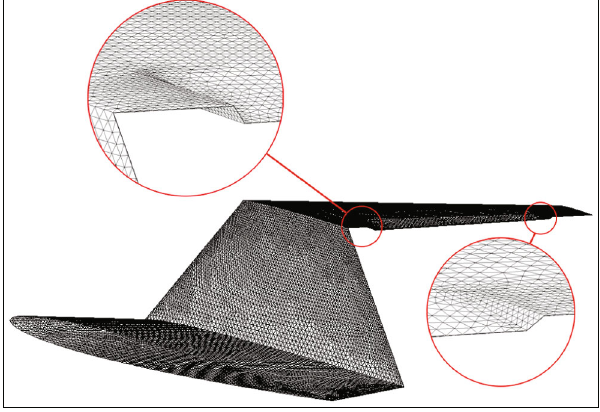
Figure 3: Wall mesh with a folding angle of 90 ° and a de fl ection angle of 10 °